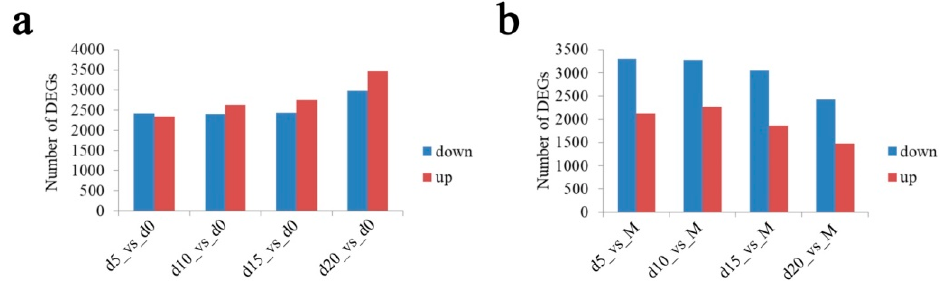
Figure 3. Bar charts of the number of up- and downregulated differentially expressed genes (DEGs) on the 5th (d5), 10th (d10), 15th (d15), and 20th (d20) days of the coculture compared with the initial values (d0 or M). ( a ) Gastrodia elata ; ( b ) Mycena sp. WM.